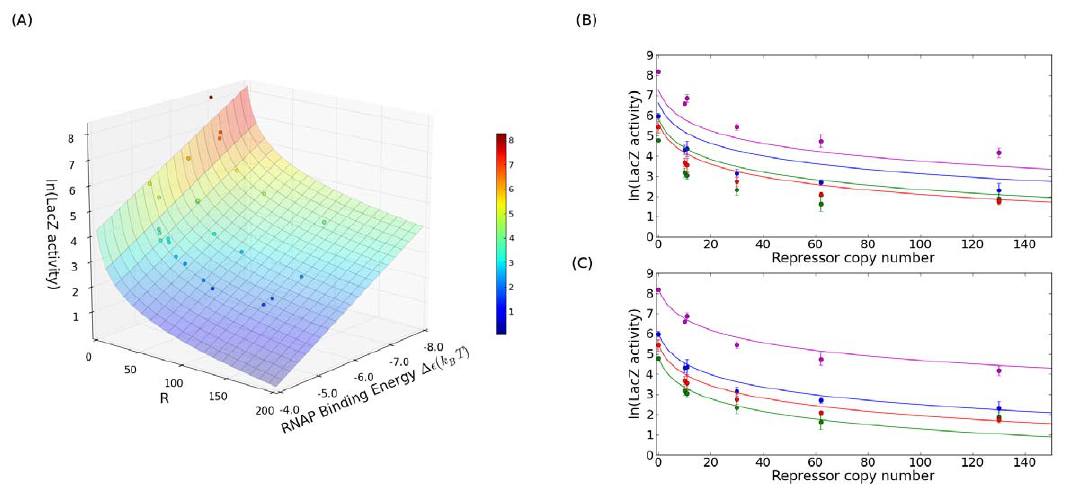
Figure 7. Gene expression in the simple repression case. (A) Solid surface: predicted gene expression of equation 7 as a function of repressor copy number R and RNAP binding energy D E . Data points represent measurements of gene expression in a strain with a given promoter and repressor copy number. (B) Data from part (A) collapsed onto the RNAP binding energy axis. The solid lines are the zero parameter predictions from the theory in equation 7 using D E predicted from the position-weight matrix in Figure 2 (numerical values listed in Figure 3 under ‘‘model’’). There is a systematic deviation between the theory and the experimental data which is inherited from the imperfect prediction of D E by the RNAP binding strength model (illustrated schematically in Figure 6. In (c) the same data are shown after we have corrected D E to fall on the theory fit line based on the constitutive expression (numerical values listed in Figure 3 under ‘‘LacZ’’). Here we see that by correcting for the initial uncertainty in the binding energy prediction we observe good agreement between the theory and experimental data which indicates that our designed promoters function as expected even in a different regulatory context.